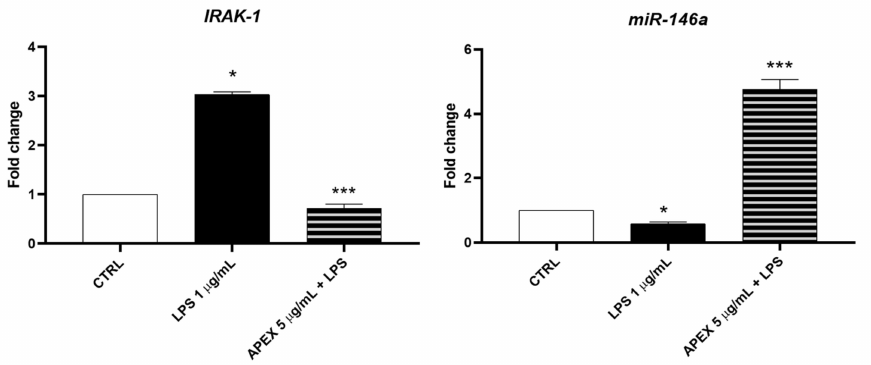
Figure 9. Effect of APEX on IRAK-1 and miR-146a expression levels in LPS-stimulated U937 cells. Treatments were the same as in Figure 6. Results are reported as fold change compared to control. Results are the mean ± SEM of three experiments. One-way ANOVA was used: * p < 0.05 CTRL vs. LPS; *** p < 0.01 LPS vs. APEX +